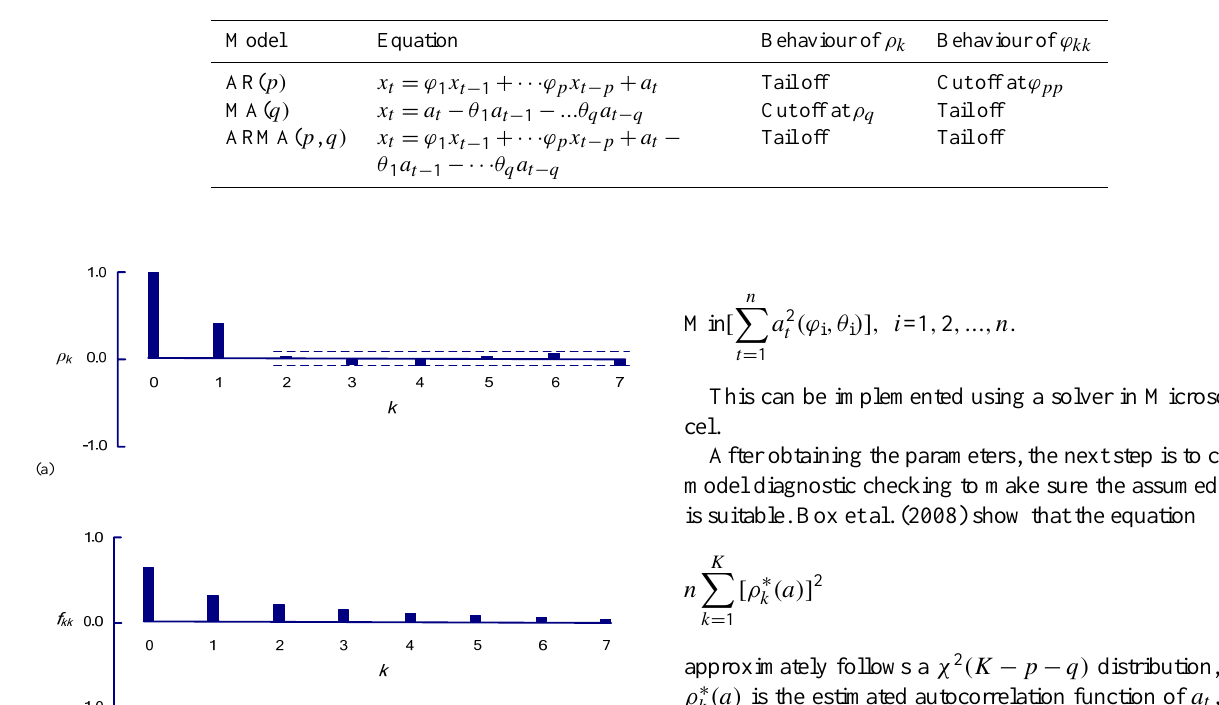
Table A1. Identification of time series.